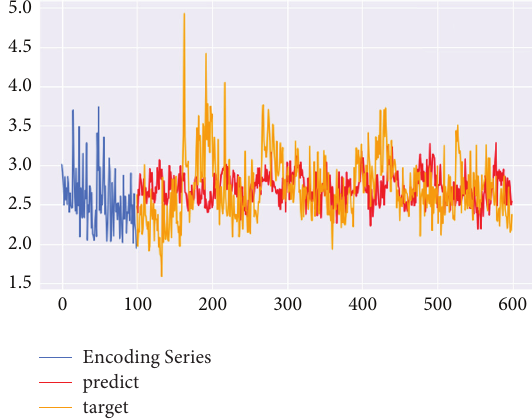
Figure 8: Performance of the Wavenet in the test